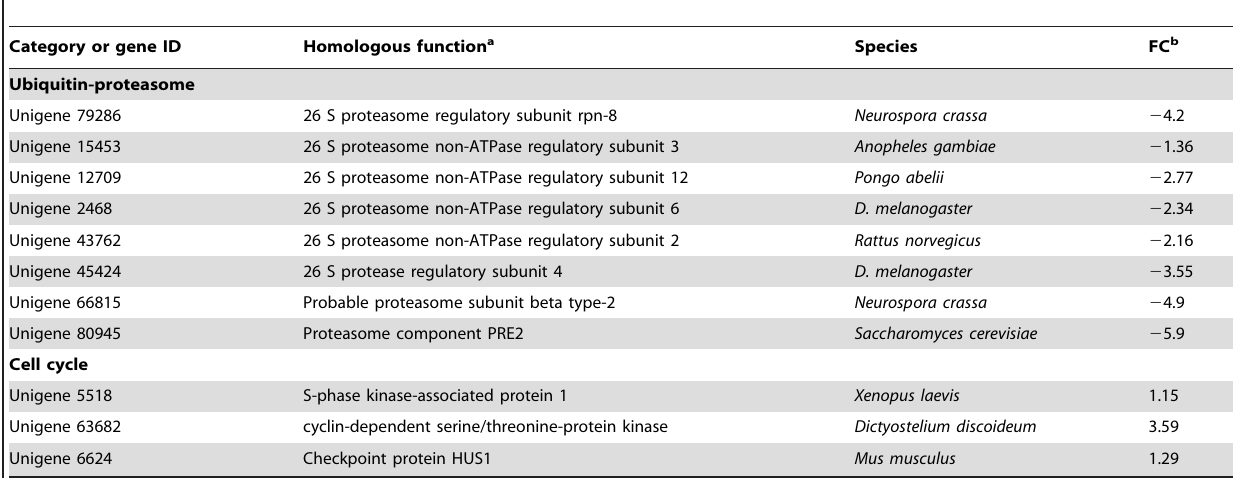
Table 3. Expression profiles of genes in the ubiquitin-proteasome and cell cycle pathways.